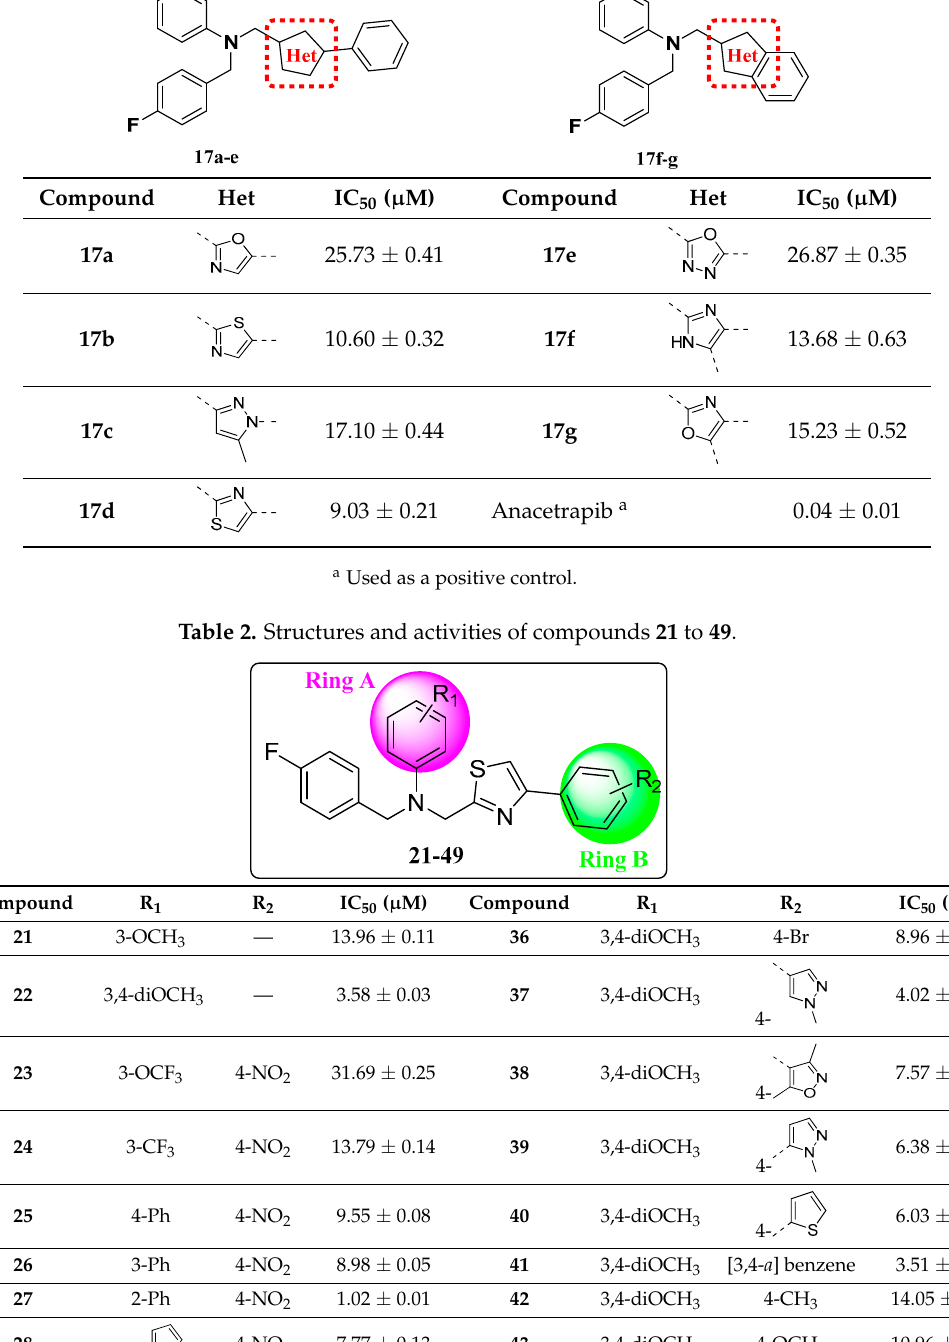
Table 1. Structures and activities of compounds 17a to g .